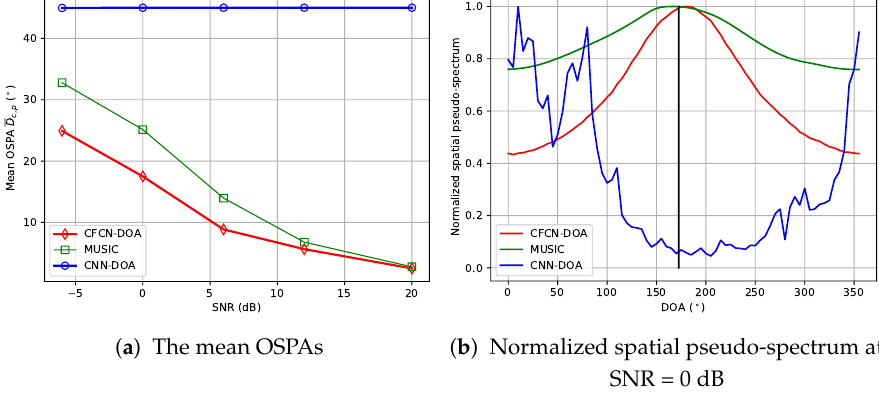
( b ) Normalized spatial pseudo-spectrum at